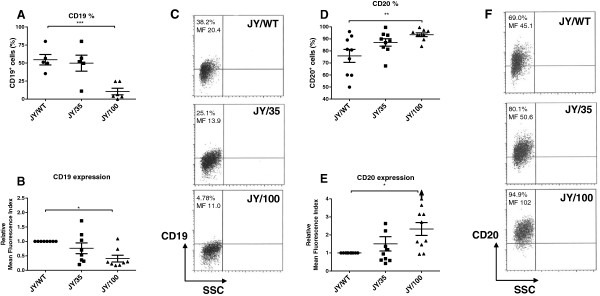
Expression of B cell surface markers CD19 and CD20 on JY/WT cells and BTZ-resistant variants. (A) Percentage CD19-positive JY/WT cells and BTZ-resistant variants. (B) Expression of CD19 in BTZ-resistant JY cells relative to JY/WT cells. Results are depicted as relative Mean Fluorescence Index (MFI) and represent the mean ± SEM of 5 separate experiments. (C) Representative figure of CD19 expression in JY/WT cells and BTZ-resistant variants. Percentages and mean fluorescence intensity are indicated in the upper left quadrant. (D) Percentage CD20-positive JY/WT cells and BTZ-resistant variants. (E) Expression of CD20 in BTZ-resistant JY cells relative to JY/WT cells. Results depicted are depicted as relative Mean Fluorescence Index (MFI) and represent the mean ± SEM of 9 separate experiments. (F) Representative figure of CD20 expression in JY/WT cells and BTZ-resistant variants. Percentages and mean fluorescence intensity are indicated in the upper left quadrant. *** p < 0.001, ** p < 0.01, * p < 0.05.